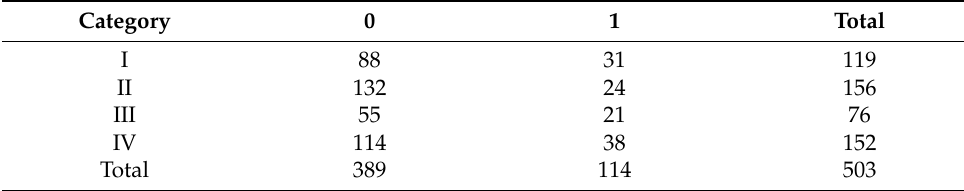
Figure 6. Clustering validity function Vcs. Table 4. Clustering results of 503 catchments.